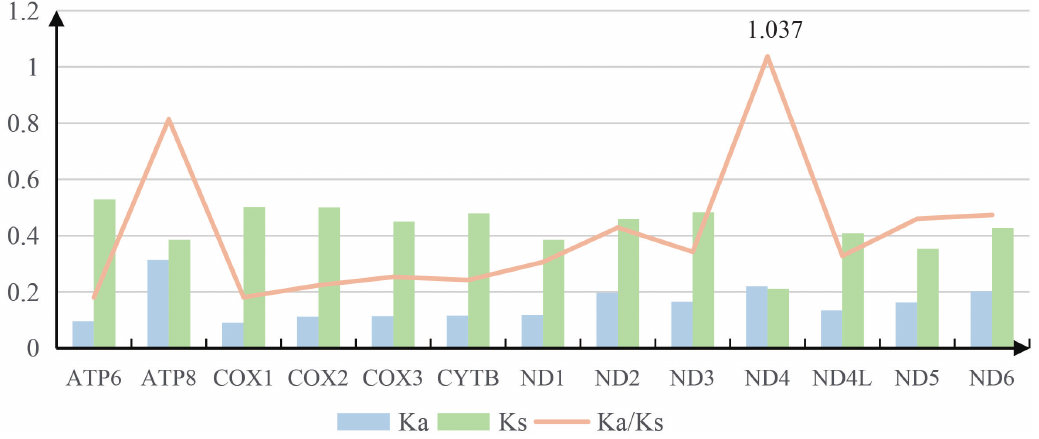
Figure 3. Evolutionary rates of 13 PCGs in between Luperomorpha xanthodera and Luperomorpha hainana . A blue boxes, green boxes, and orange line indicate the non-synonymous substitutions rate (Ka), the synonymous substitutions rate (Ks), and the ratio of the rate of non-synonymous substitutions to the rate of synonymous substitutions (Ka/Ks),